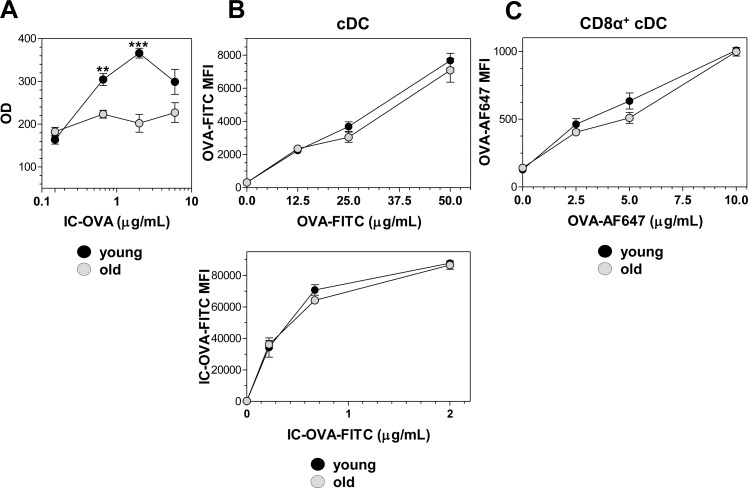
Ag presentation on MHC I molecules is affected in cDCs from old mice but Ag uptake is preserved.(A) In vitro Ag presentation assay. cDCs purified from the spleen of young and old mice were incubated with several OVA concentrations forming IC-OVA for 4 hours and then they were washed and incubated with B3Z cells overnight. B3Z stimulation, monitored by colorimetric bulk determination of β-galactosidase, is expressed as optical density (OD) at λ = 595. (B, C) In vitro Ag capture assay. (B) Spleen cells from young and old mice were recovered and incubated for 90 minutes with soluble OVA-FITC (upper) or IC-OVA-FITC (lower). Then, spleen cells were labeled with anti-CD11c Ab. Results are expressed as mean ± SEM of MFI in FITC channel. (C) CD8α+ cDCs purified from young and old mice were incubated for 90 minutes with soluble OVA-AF647. Results are expressed as mean ± SEM of MFI in AF647 channel. Results are representative of 3 independent experiments (3–4 mice/age group/experiment).